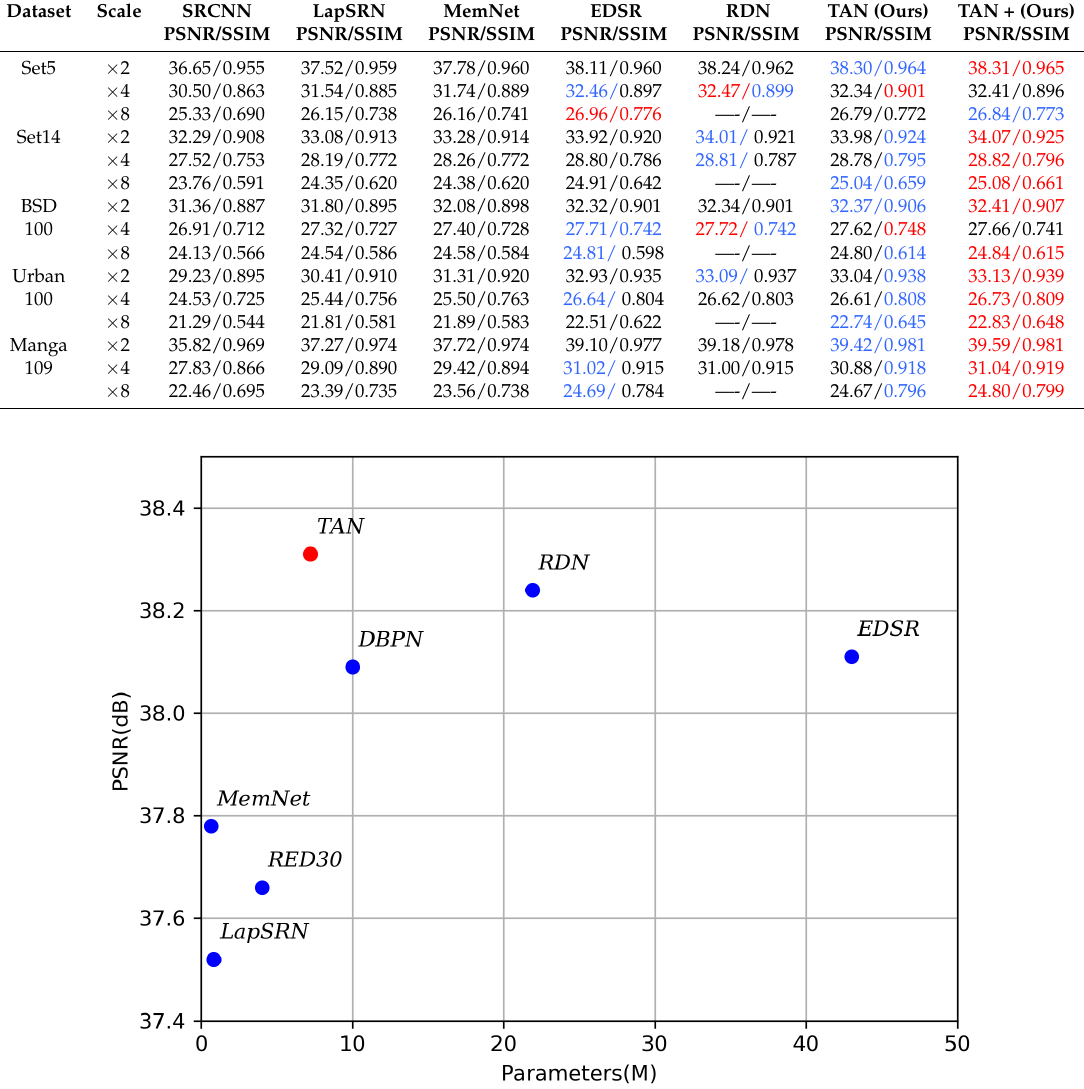
Table 1. Compare with state-of-the-art methods. The best result is marked with red and the second is marked with blue.